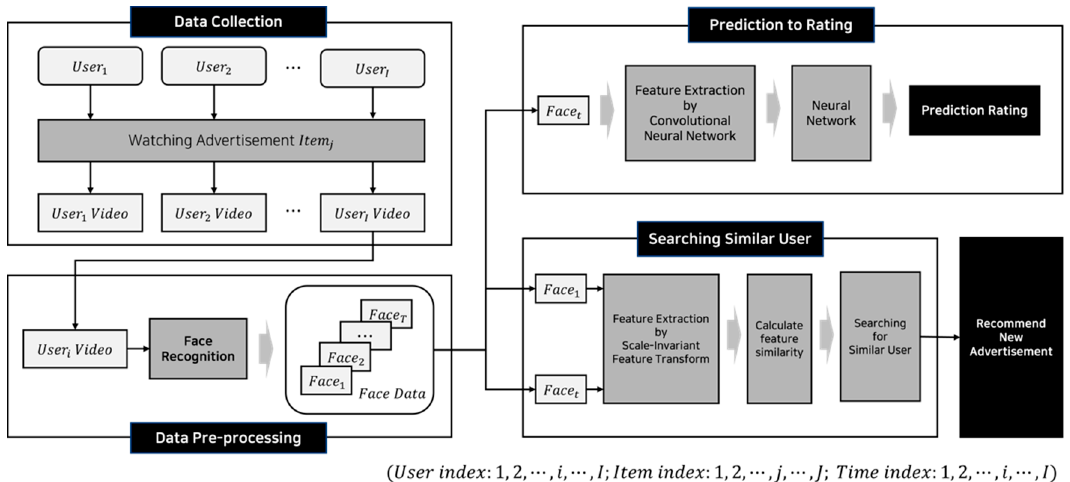
Figure 1. The overall process of the proposed methodology.